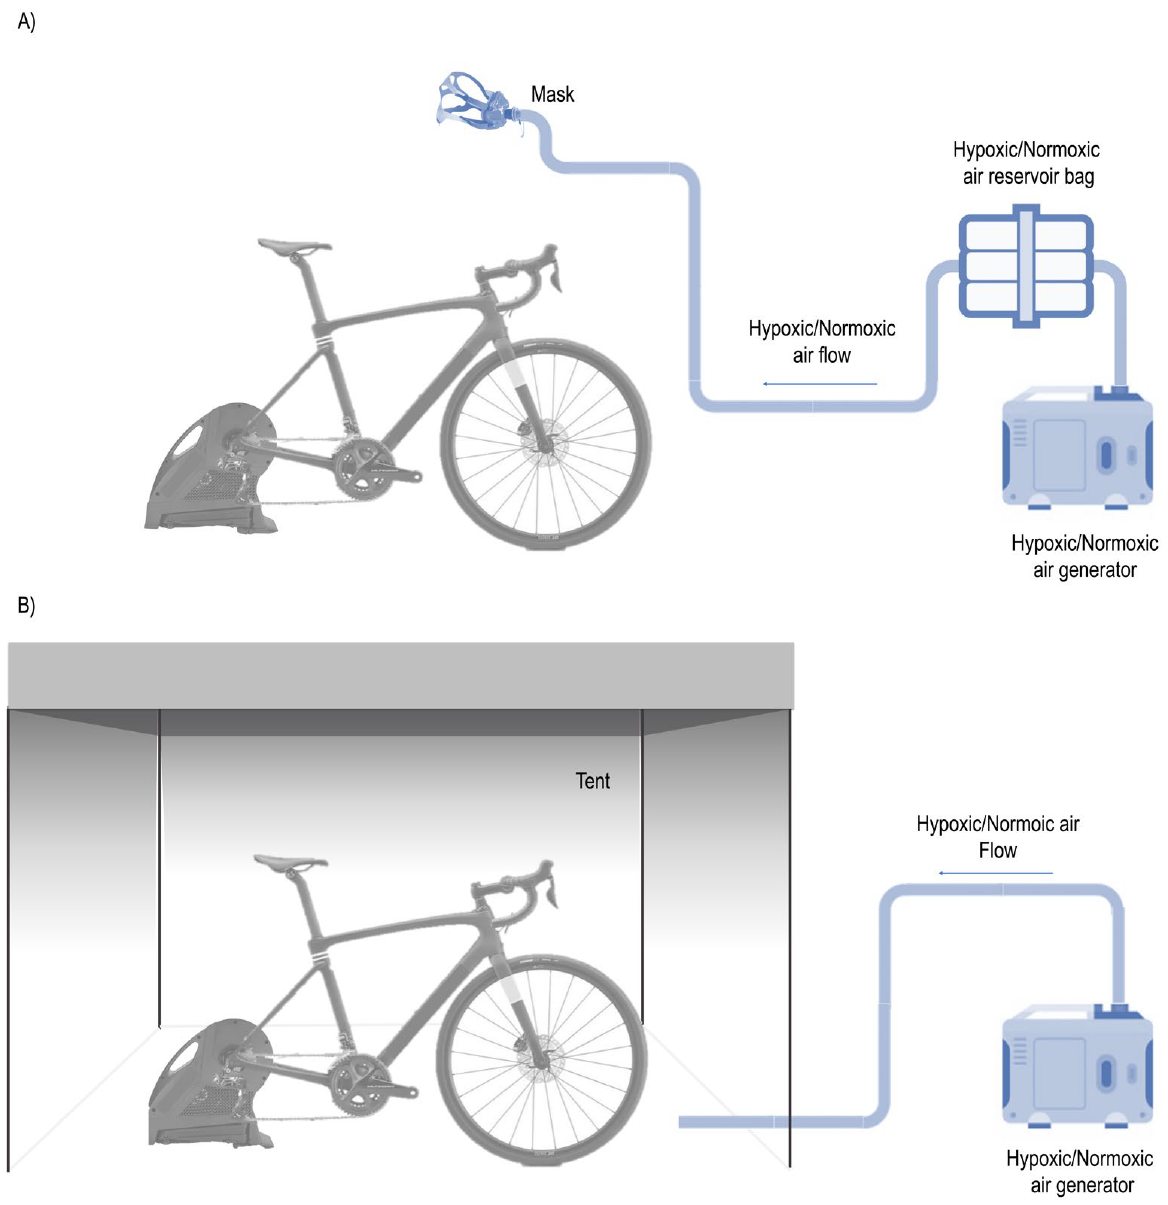
Figure 2. Training systems in normobaric hypoxia. ( A ) System setting for RSH Mask = repeated-sprint in normobaric hypoxia using a mask and RSN Mask = repeated- sprint in normoxia using a mask. ( B ) System setting for RSH Tent = repeated-sprint in normobaric hypoxia and RSN Tent = repeated-sprint in normoxia using a tent.